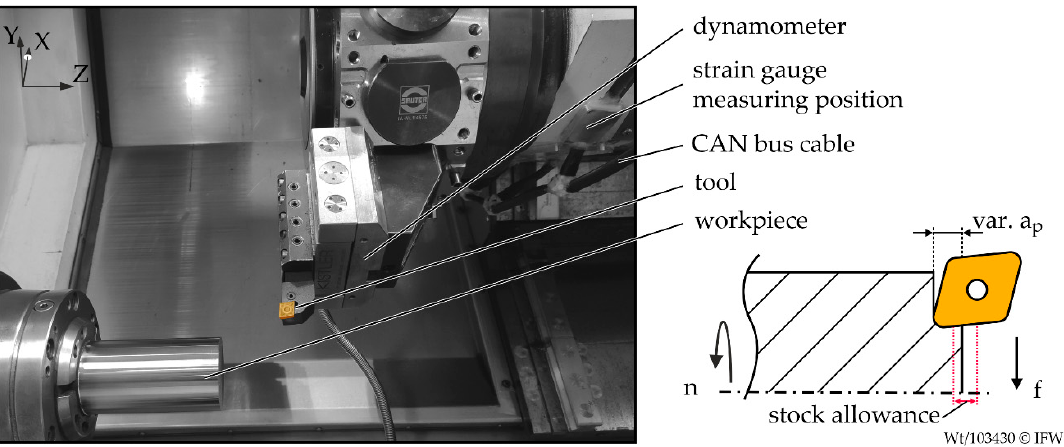
Figure 1. Presentation of the measurement setup.